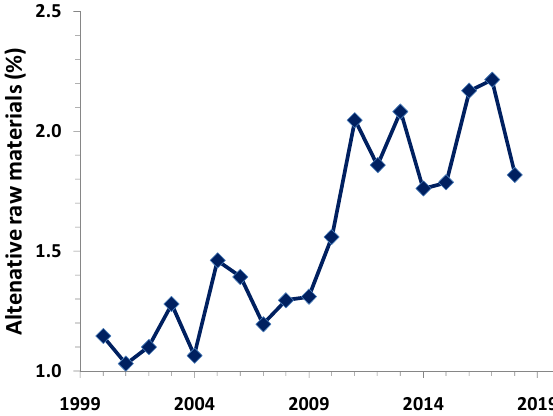
Figure 4. Alternative raw materials consumption by the Spanish cement industry from 2000 to 2018.